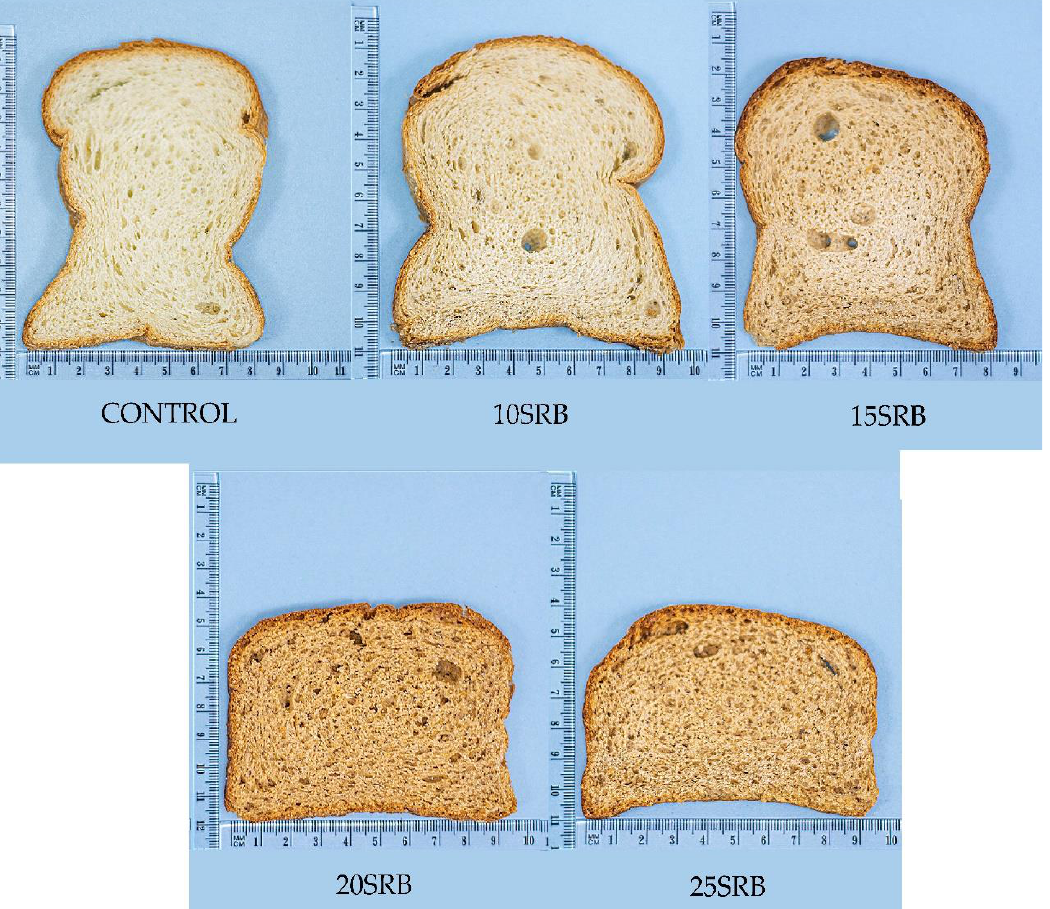
Figure 1. Breads formulated with different percentages of SRB. Abbreviations: 10SRB: formulation with 10% of SRB; 15SRB: formulation with 15% of SRB; 20SRB: formulation with 20% of SRB; 25SRB: formulation with 25% of SRB. The scale of the figure is in cm.